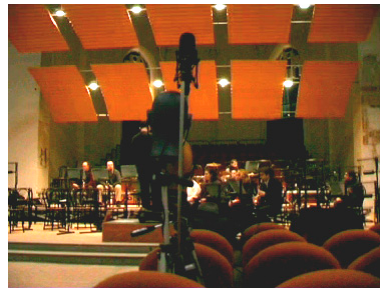
Figure 8. Existing reflectors in S. Dominic of Foligno.